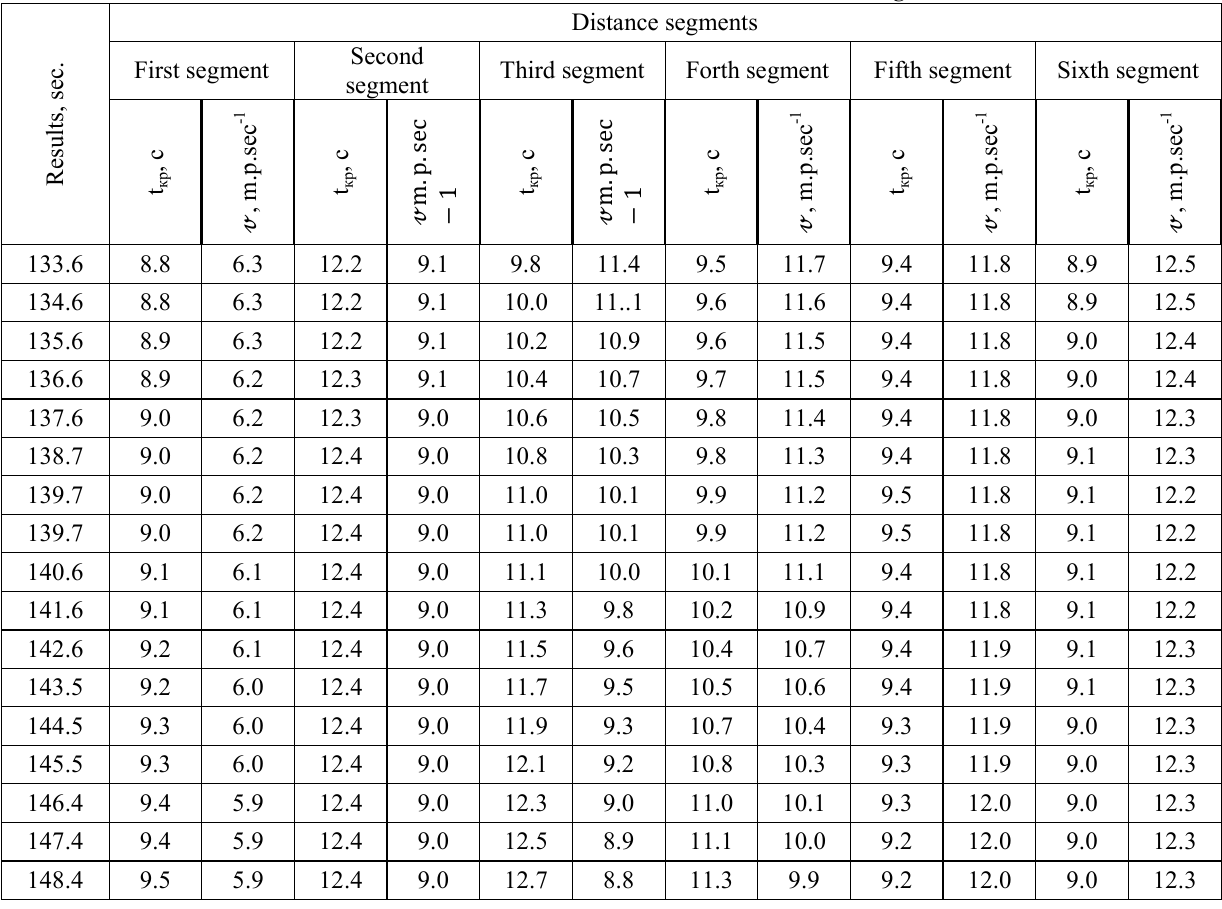
Quantitative characteristics of regression models of competition activity, which ensure achievement of desired results at 1500 meters distance in short track with second racing